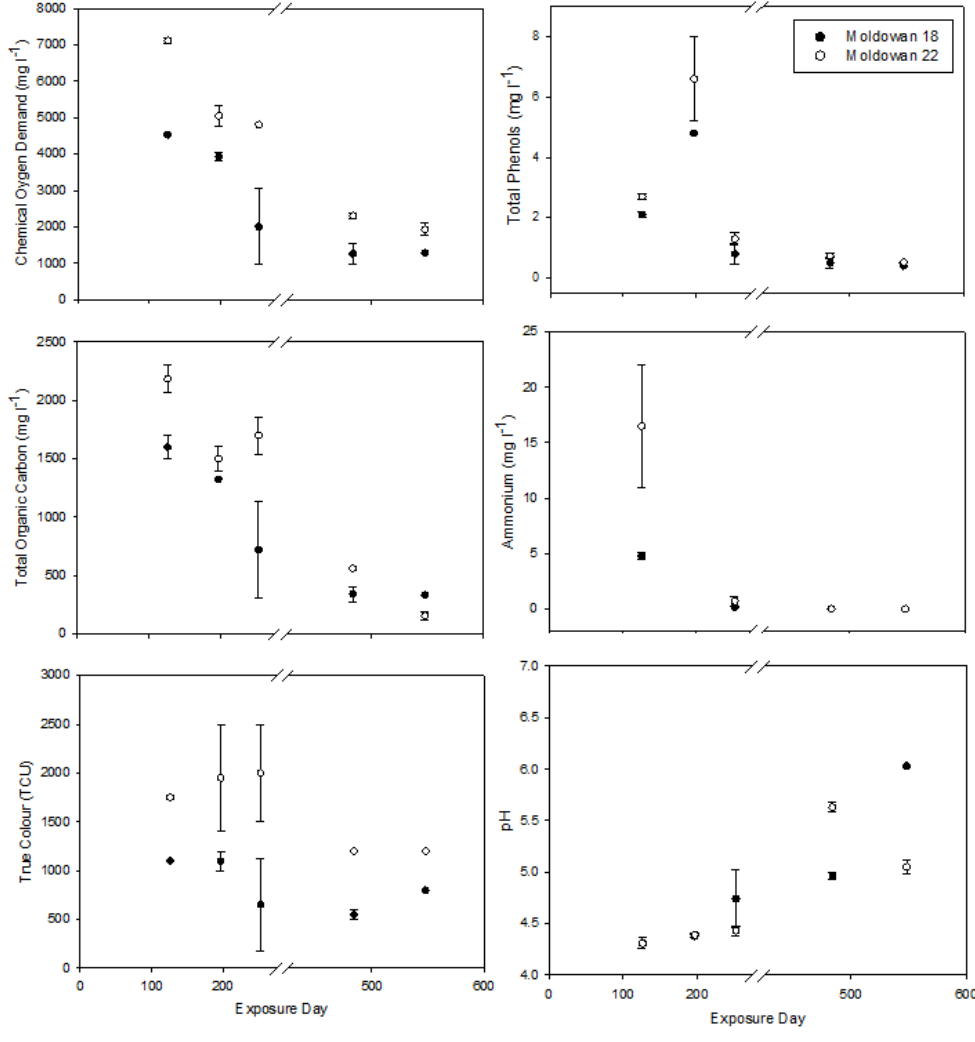
Figure 2. Operational site leachate conditions during the 548-day exposure period. Error bars represent standard error ( n = 2).